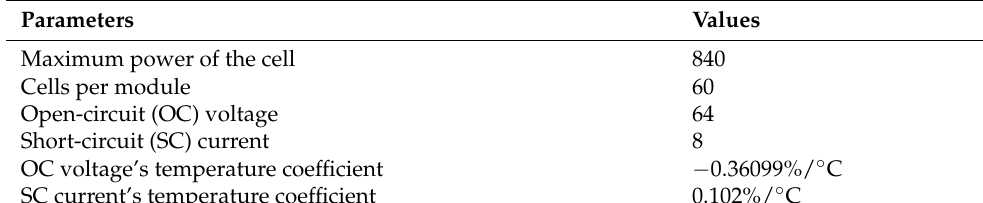
Table 2. Solar-array specifications [10].